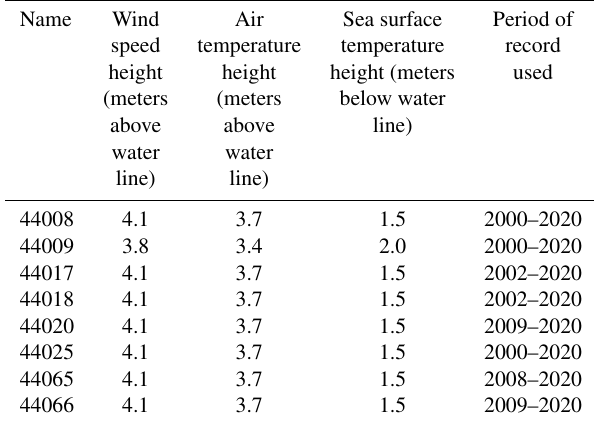
Table 3. List of NDBC buoys used in this